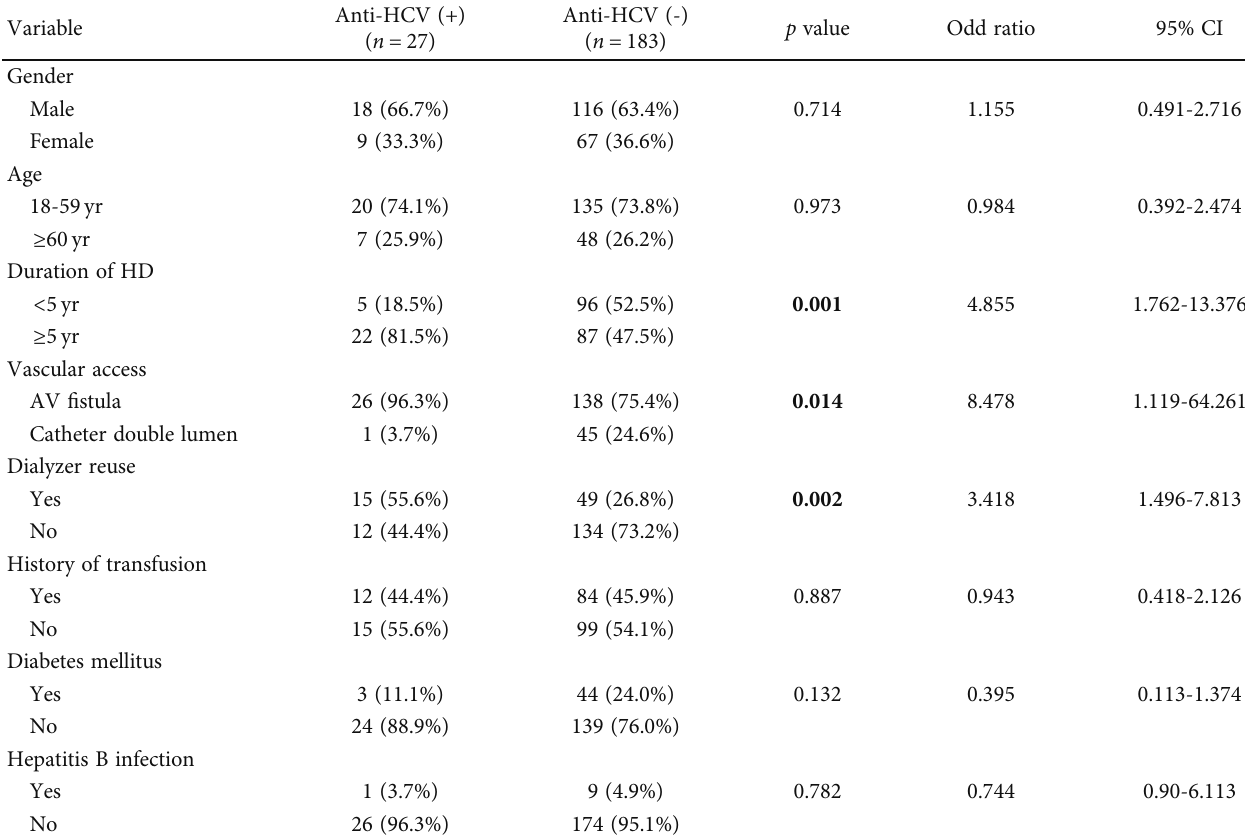
Table 3: Association of risk factors with HCV infection in hemodialysis patients (hospital